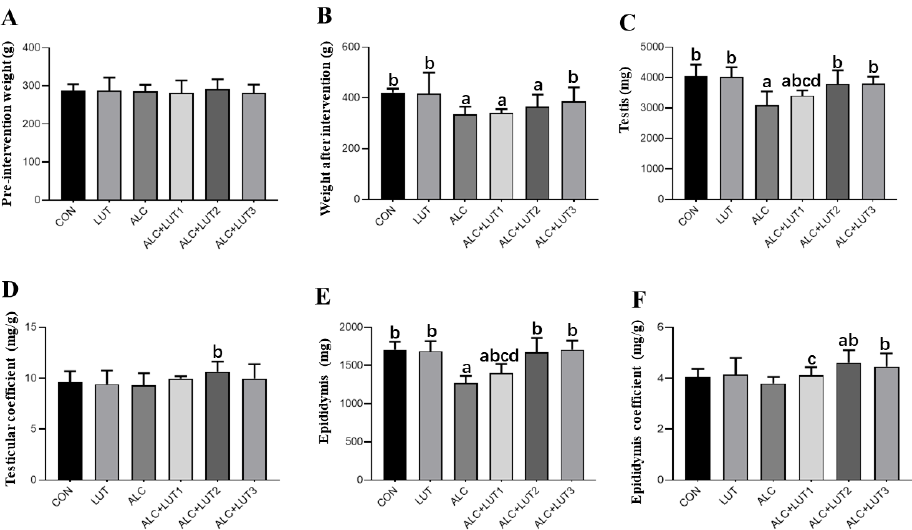
Figure 1. Body weights and organ weights. ( A ) Pre-intervention weight; ( B ) Weight after intervention; ( C ) Testicular weight; ( D ) Testicular coefficient; ( E ) Epididymis weight; ( F ) Epididymis coefficient. CON: control group; LUT: Lutein alone supplement group; ALC: alcohol model group; ALC + LUT1: alcohol + low-dose Lutein group; ALC + LUT2: alcohol + medium-dose Lutein group; ALC + LUT3: alcohol + high-dose Lutein group; a, vs. the CON group, p < 0.05; b, vs. the ALC group, p < 0.05; c, vs. the ALC + LUT2 group, p < 0.05, d, vs. the ALC + LUT3 group, p < 0.05 (n = 10, mean ±